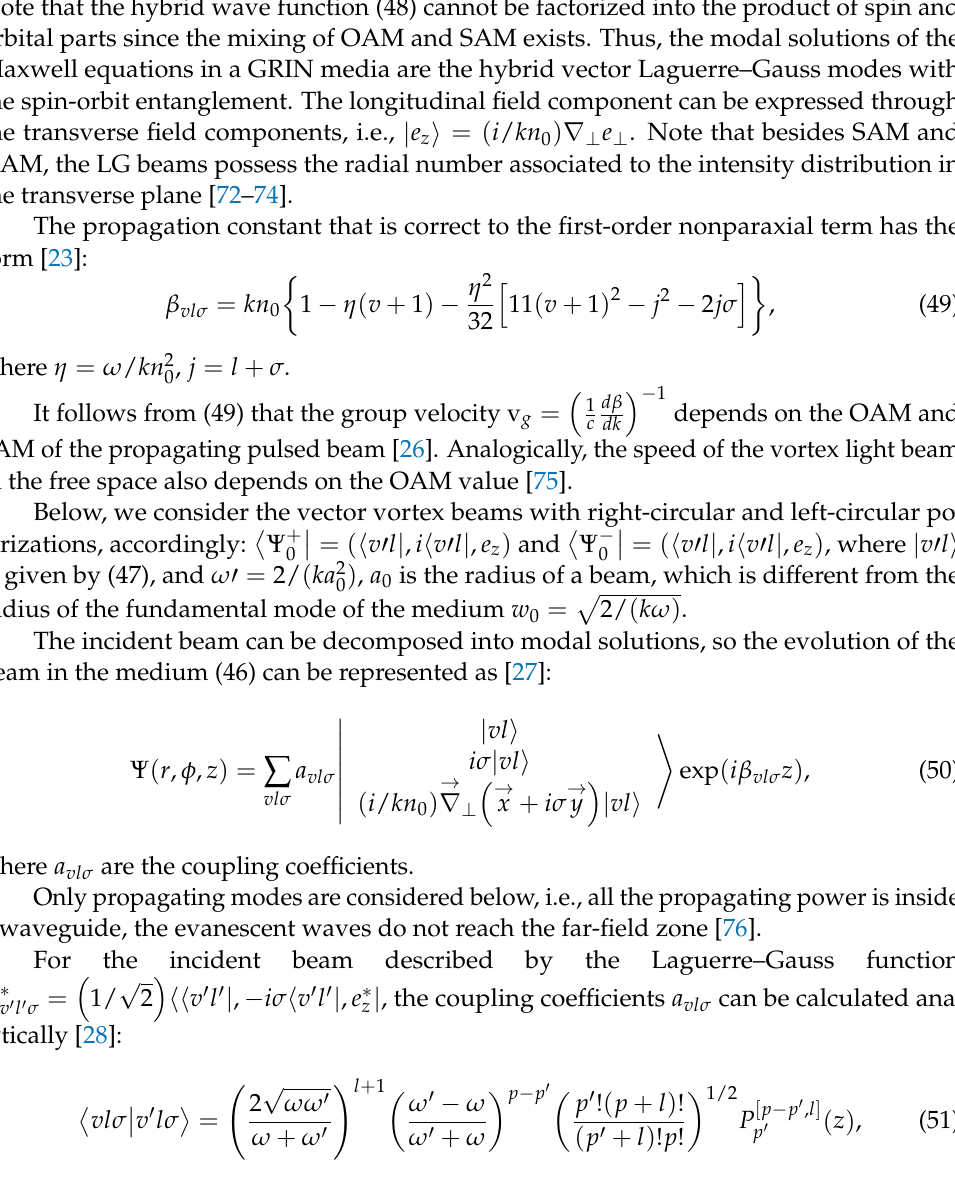
Figure 7. Field amplitudes of even modes | 00 (cid:105) , | 20 (cid:105) , | 22 (cid:105) ( a ) and odd modes | 11 (cid:105) , | 31 (cid:105) ( b ). There is no mode conversion at propagation if the incident beam is expressed by